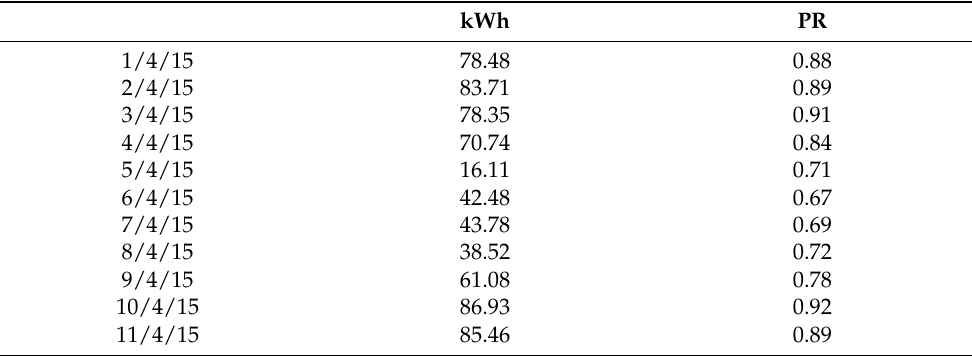
Table 6. Energy production and PR for the period 1 April 2015–11 April